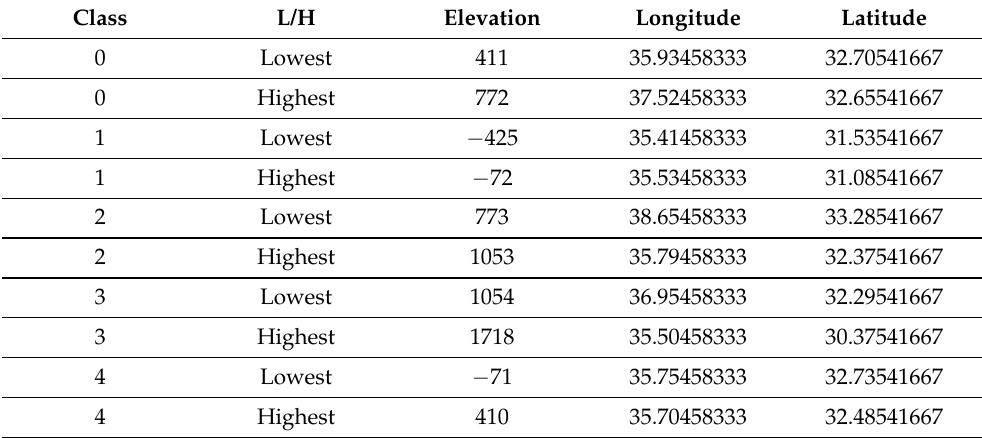
Table 4. Elevation—lowest and highest value–longitude and latitude in each cluster with K =